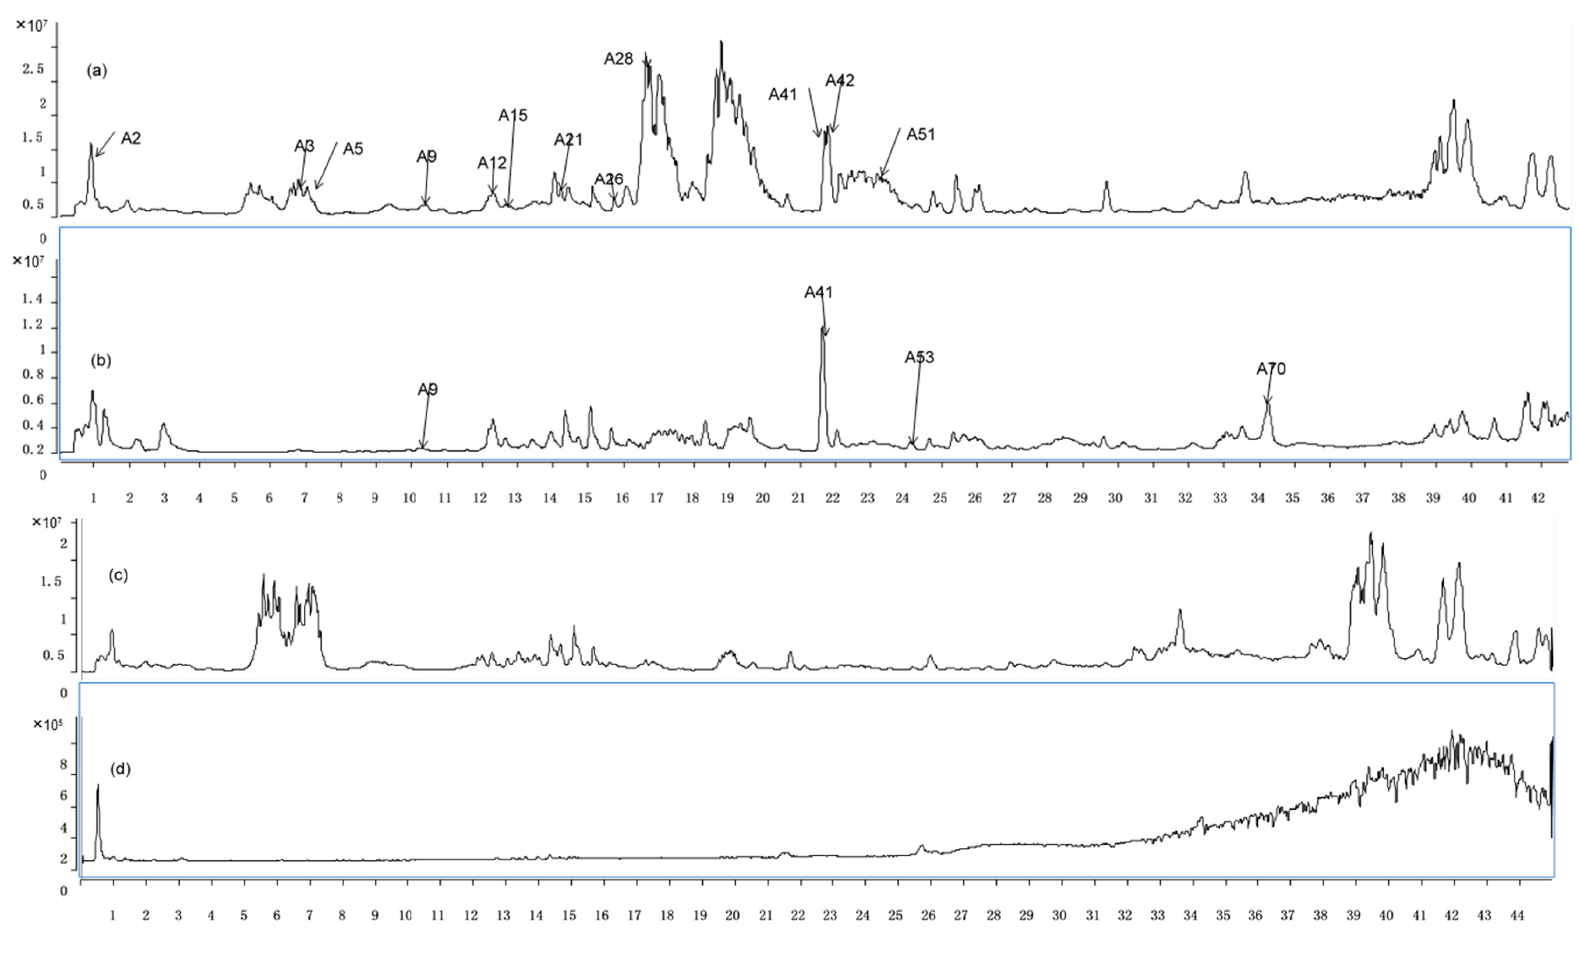
Figure 2. RRLC-Q-TOF-MS chromatograms of 15 prototype components in dosed and blank rat plasma. ( a ) Total ion chromatogram (TIC) of dosed rat plasma in negative mode; ( b ) TIC of dosed rat plasma in positive mode; ( c ) TIC of blank rat plasma in negative mode; and ( d ) TIC of blank rat plasma in positive mode.